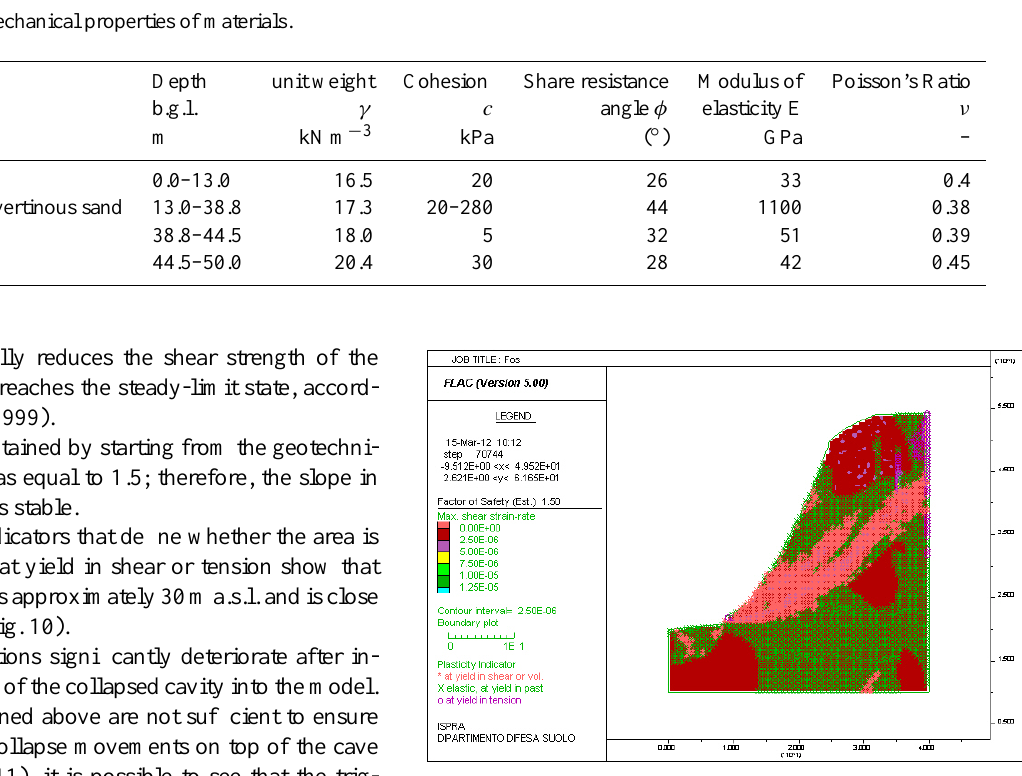
Fig. 10. Section 1. Safety factor and plasticity indicator. In the summit area of the slope, the shear strain rate distribution does not show a well-defined plane of shear failure, but a general state of collapse. The plastic indicators show a state of spread yield at the altitude of 30ma.s.l., corresponding to the position of the caves. The simulation is not really significant in the vicinity of the right peripheral zone, due to an “edge effect”. The strength values repre- sent the shear strength of the slope material before the application of the reduction